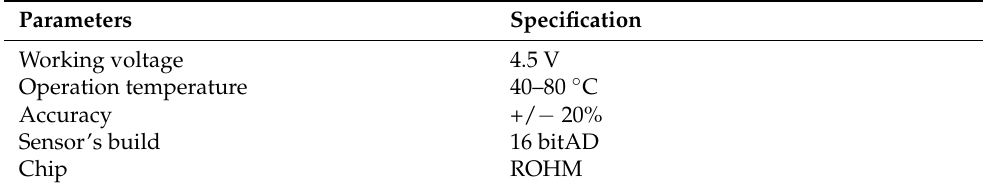
Table 4. The manufacturer’s specification of the BH1750